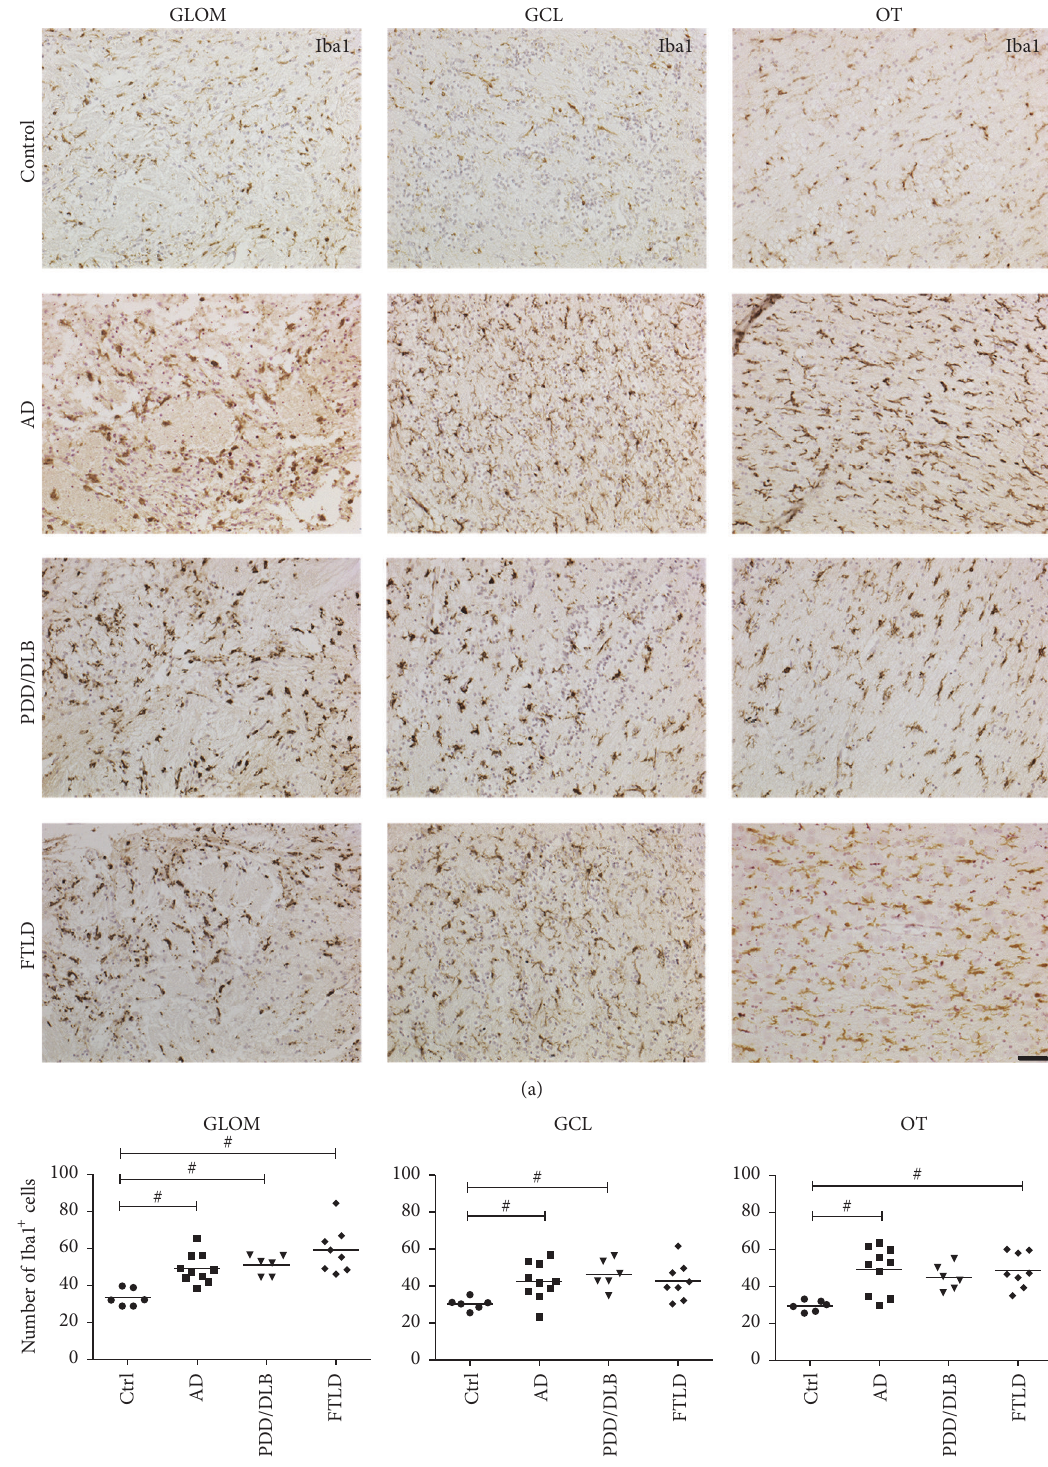
Figure 3: Increased numbers of Iba1 expressing microglia cells in the GLOM, GCL, and OT of the OB from AD, PDD/DLB, and FTLD cases. In the GLOM a significant increase in the number of Iba1+ microglia compared to controls was present in these diseases. Interestingly, the number of microglia was significantly higher in the GCL in AD and PDD/DLB patients, while the number of Iba1+ microglia was increased in the OT of AD and FTLD patients, but not PDD/DLB cases compared to controls. Representative images showing microglia in respective regions of the OB in (a) and quantification of Iba1+ cells in (b). 1-way ANOVA, Kruskal Wallis post hoc test, # 𝑝 < 0.05 . Scale bar represents 50 𝜇